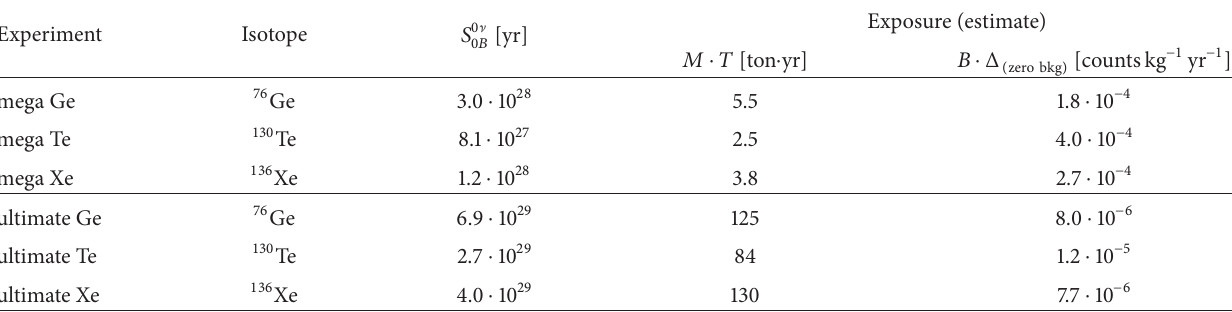
Table 10: Sensitivity and exposure necessary to discriminate between NH and IH : the goal is 𝑚 𝛽𝛽 = 8 meV. The two cases refer to the (mega) and 𝑔 𝐴 = 𝑔 (ultimate). The calculations are performed assuming zero background experiments unquenched value of 𝑔 𝐴 = 𝑔 nucleon phen . with 100 % detection efficiency and no fiducial volume cuts. The last column shows the maximum value of the product 𝐵⋅Δ in order to actually comply with the zero background